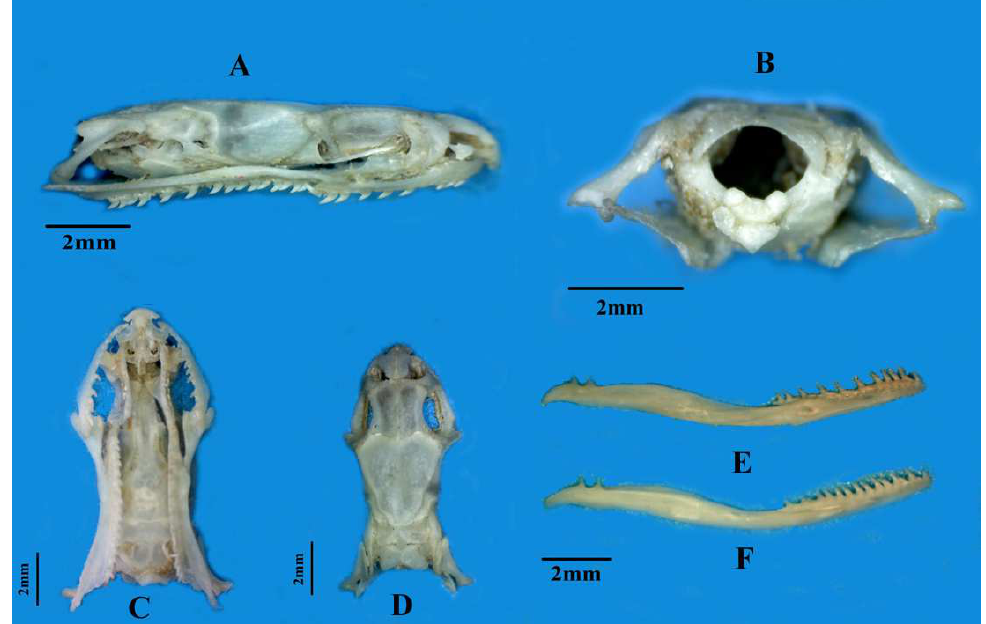
F IGURE 1. Eirenis collaris skull. Lateral view (A); posterior view (B); ventral view (C); dorsal view (D); dorsal view of lower jaw (E); ventral view of lower jaw (F).